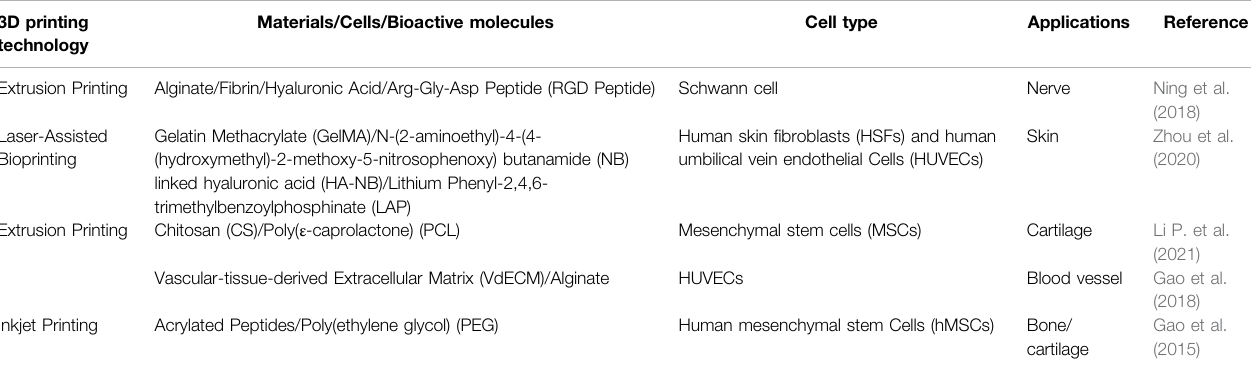
TABLE 3 | Applications of 3D printing